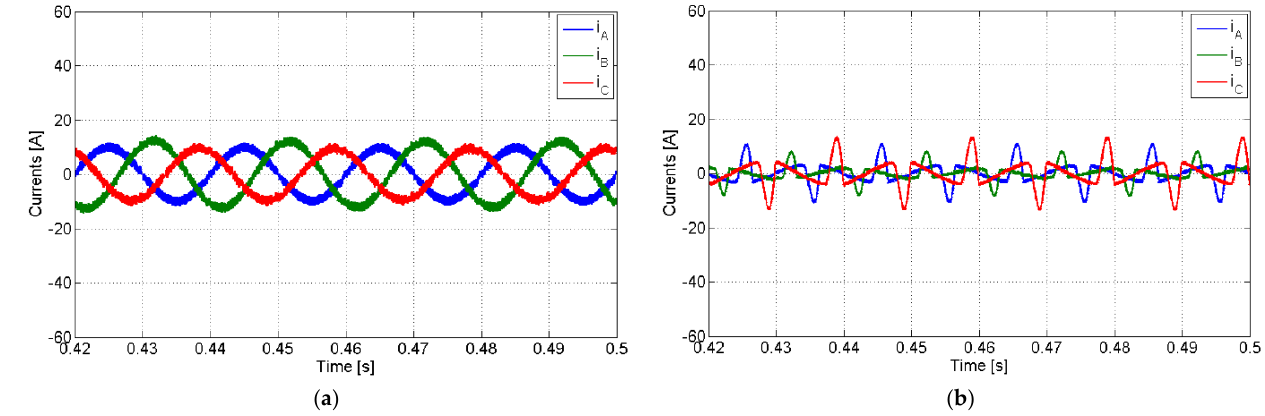
Figure 18. Simulation results with the PV generator in full compensation mode with a non-linear load and compensation of the active power imbalance: ( a ) AC currents of the PV generator; ( b ) grid currents.